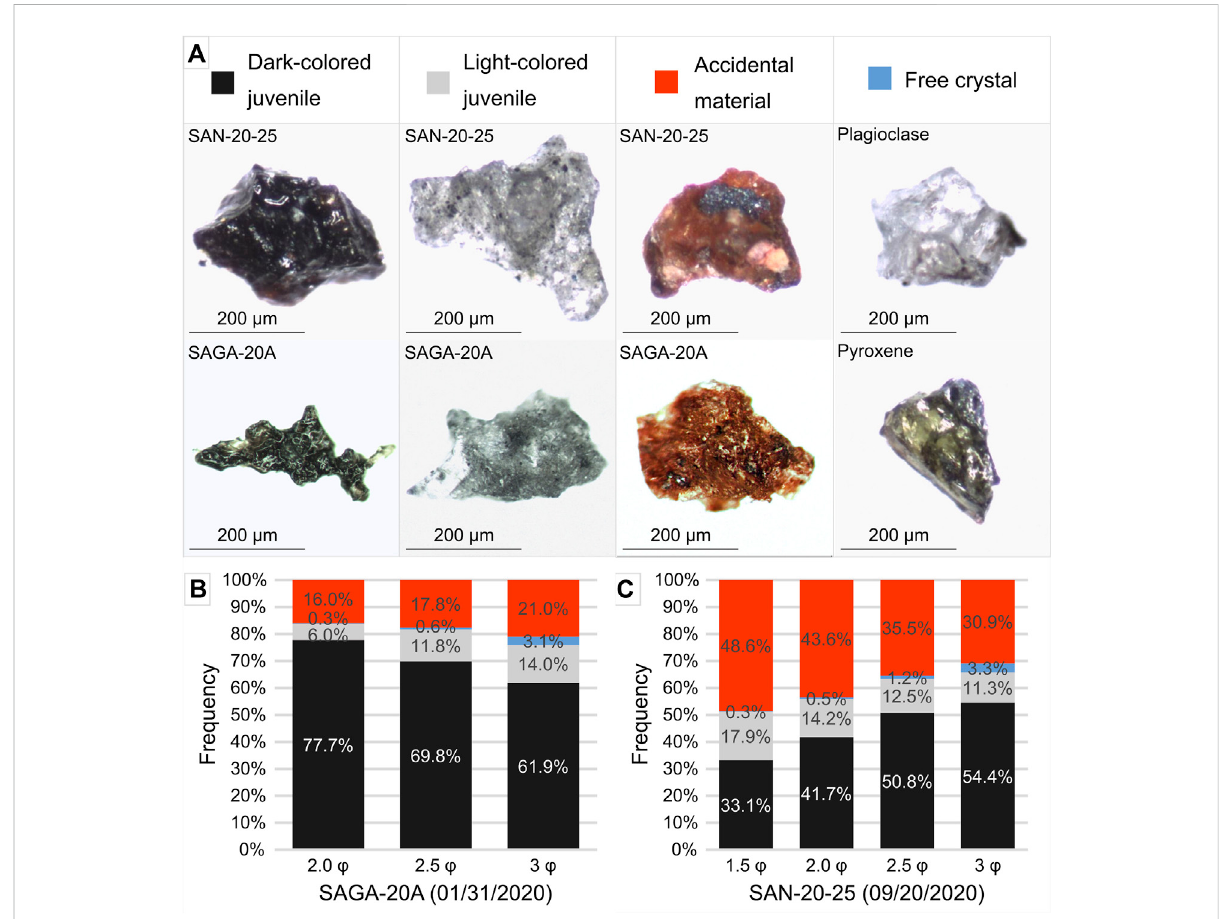
FIGURE 10 Optical classi fi cation and componentry analysis of the Sangay ash samples. (A) Dark colored juvenile fragments are black to brown, glassy, translucent to opaque, massive to vesicular, various shapes (blocky, sub-rounded, irregular); Light-colored juvenile fragments are light gray, glassy, translucent, massive, blocky to sub-rounded; Accidental material is variously colored (mostly red, dark gray, white), dull, opaque, variously shaped (blocky, sub-rounded, irregular); Free crystals are white (plagioclase) and green (pyroxene), shiny, translucent and blocky. (B) The 2.0 φ , 2.5 φ and3.0 φ fractionsrepresentrespectively2.6%,6.6%and11.5%oftheSAGA-20Asampleaccordingtothegrainsizeanalysis. (C) The1.5 φ ,2.0 φ ,2.5 φ and 3.0 φ fractions represent respectively 6.5%, 11.5%, 11.4% and 8% of the SAN-20 – 25 sample according to the grain size